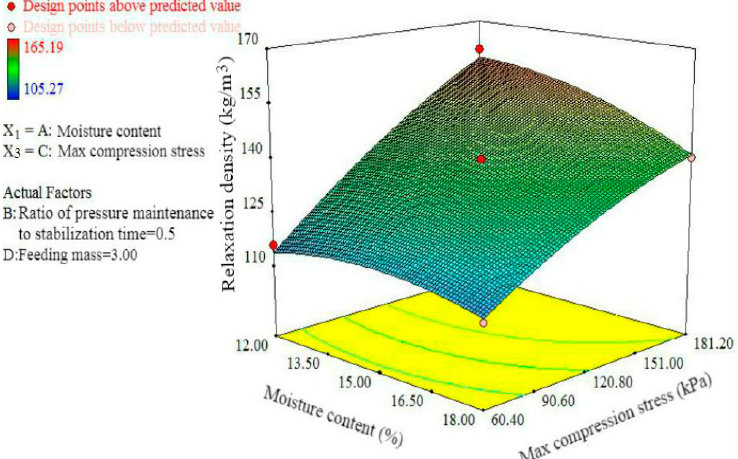
Figure 4. E ff ects of moisture content and max compression stress on relaxation density (ratio of pressure maintenance to stabilization time of 0.5 and feeding mass of 3